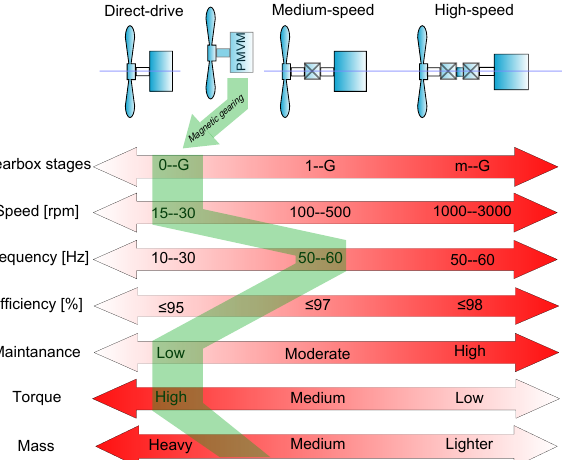
Figure 1. PMVM vs. DD-PMSM and MS-PMSM characteristics at utility power levels (©[2020] IEEE. Reprinted, with permission from